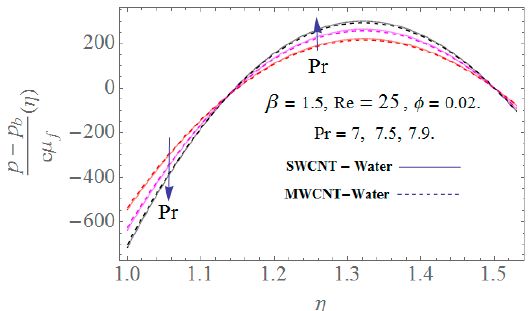
Figure 11. The impact of the Prandtl number versus the velocity field.